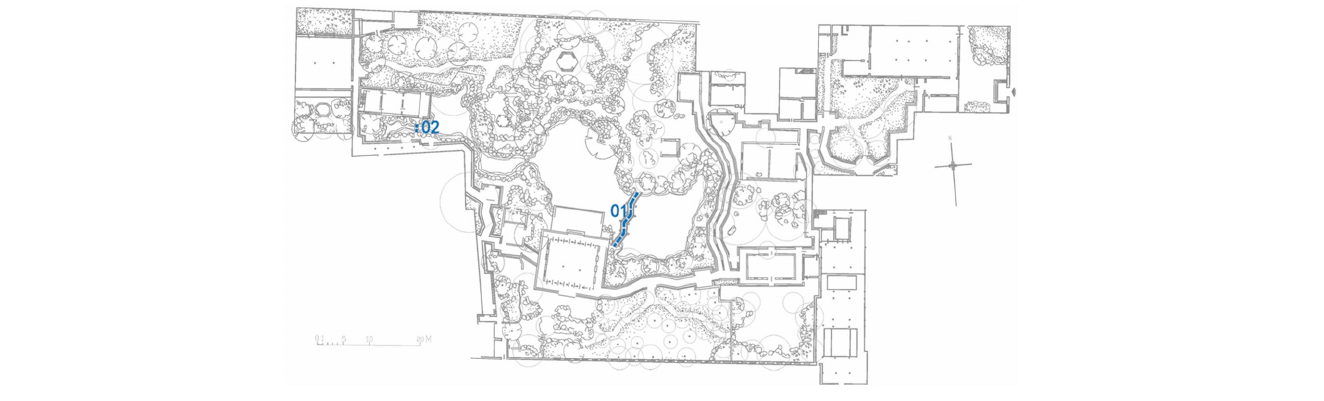
Table A24. Garden of Harmony, bridge.